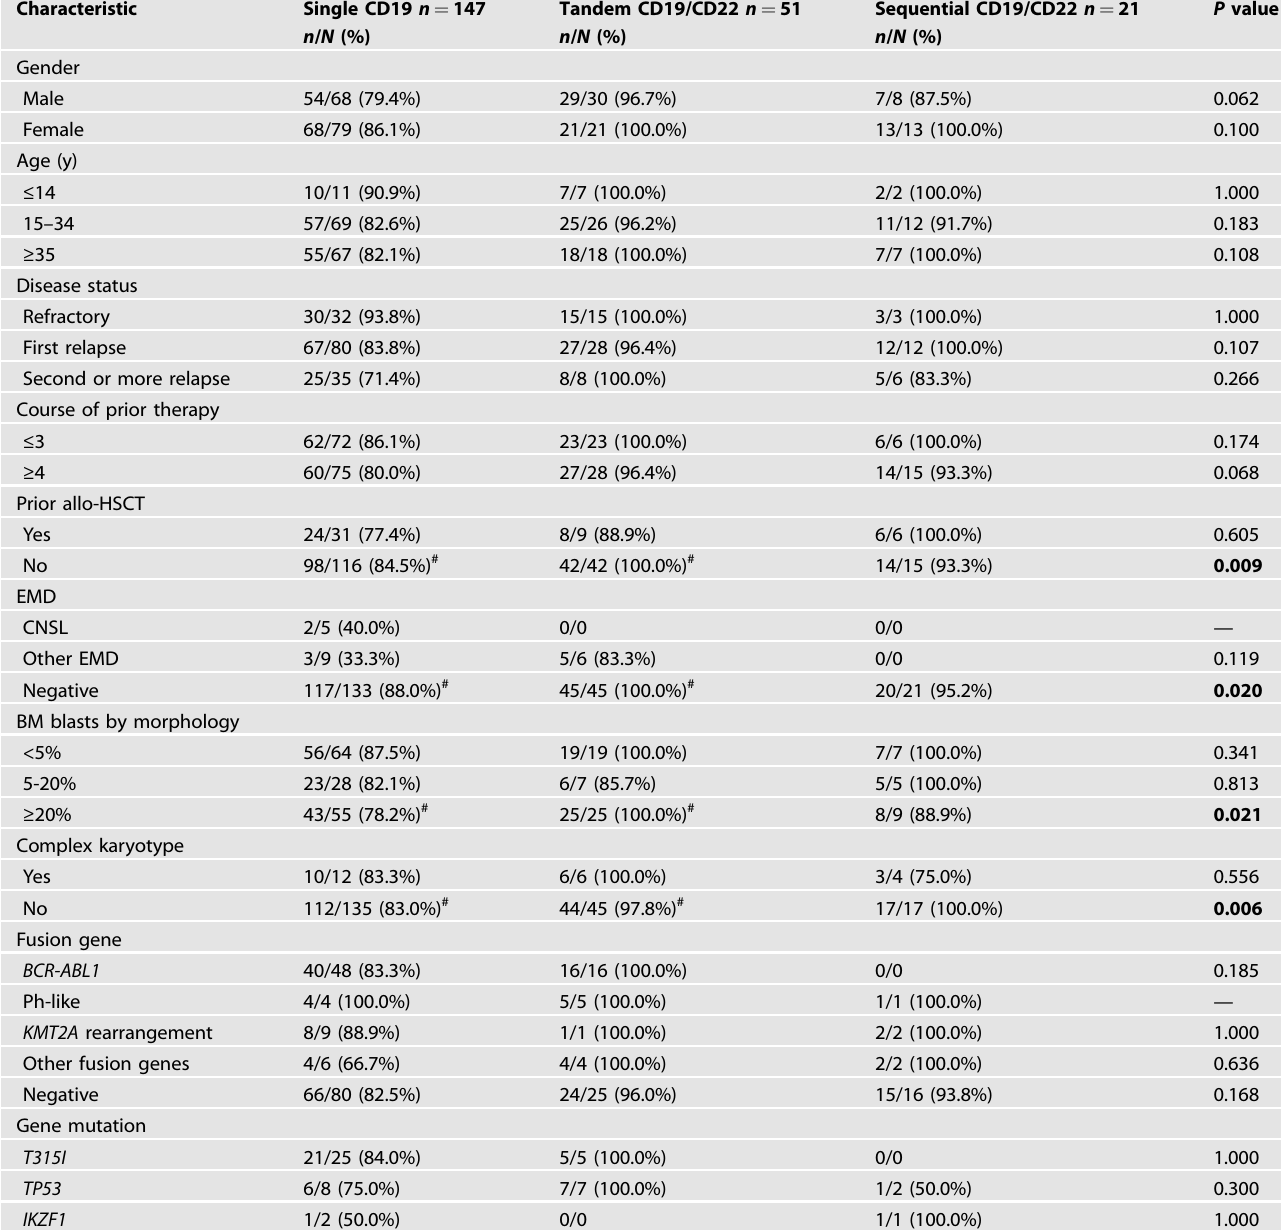
# Statistically signi fi cant difference between the two groups. Bold values indicates statistically signi fi cant p values less than